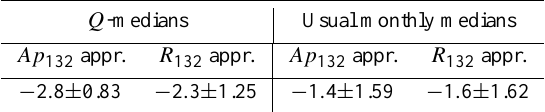
Table 3. Average optimal time shift with ± SD between δ fo F2 and Ap 132 (or R 132 ) approximated variations calculated from the results of Tables 1 and 2